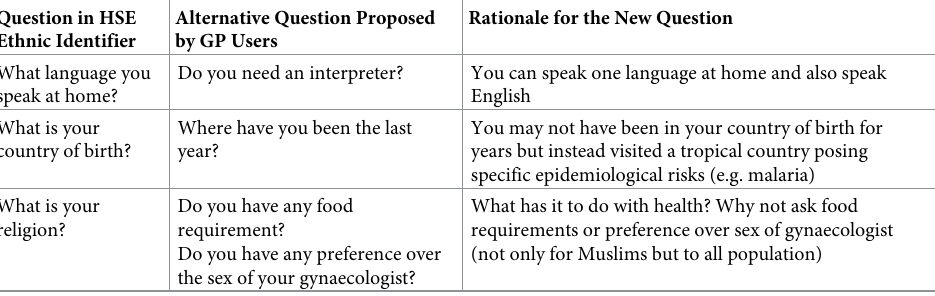
Table 5. Main critiques and proposed alternatives to the HSE ethnic identifier